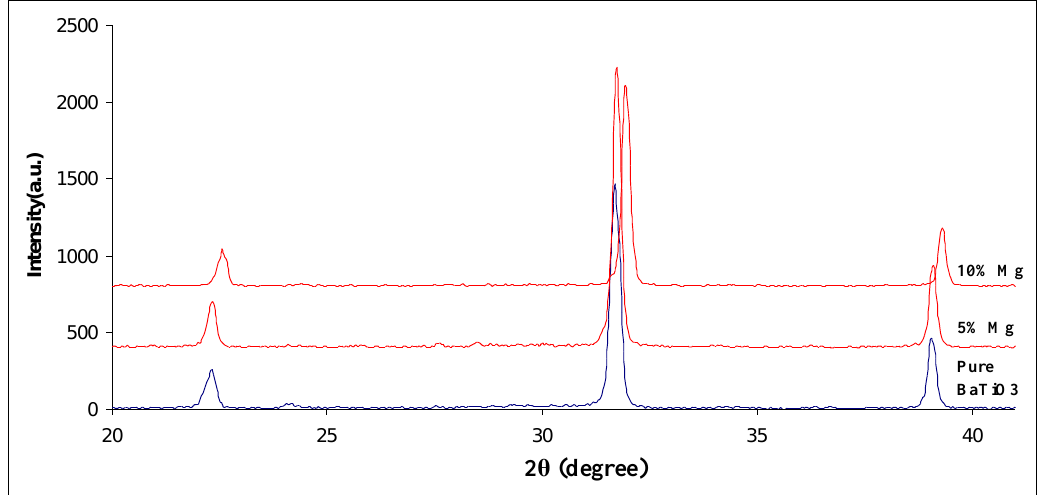
Fig. 9: The shifted of the first three peaks of (BMT) at 1000 ° C.